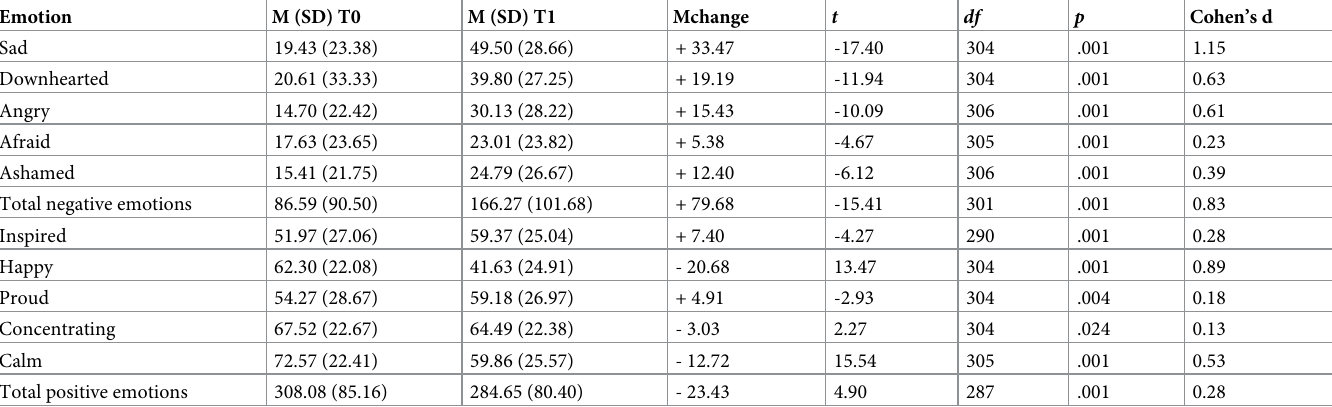
Table 3. Negative and positive emotions before and after watching the National Commemoration, and significance of the change.